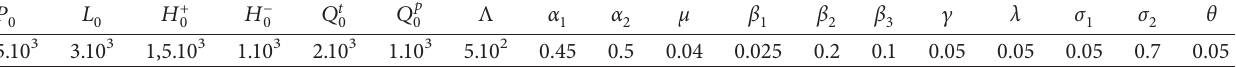
Table 1: The description of parameters used for the definition of discrete time system (1). We used just arbitrary academic data.